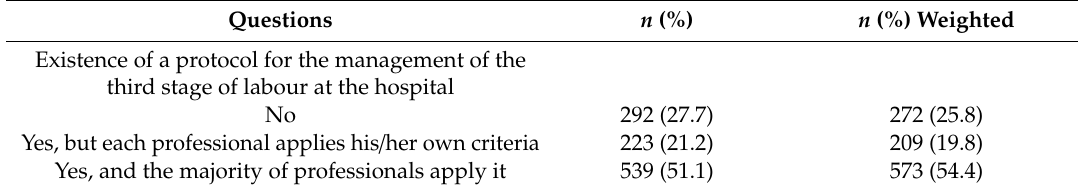
Table 2. Clinical practices during the third stage of labour for all